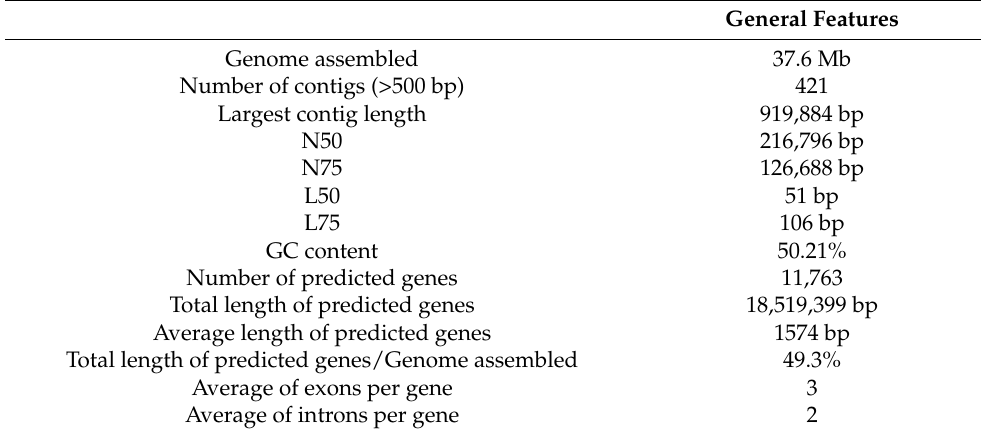
Table 2. General statistics of the Aspergillus affinis CMG 70 genome assembly, and gene